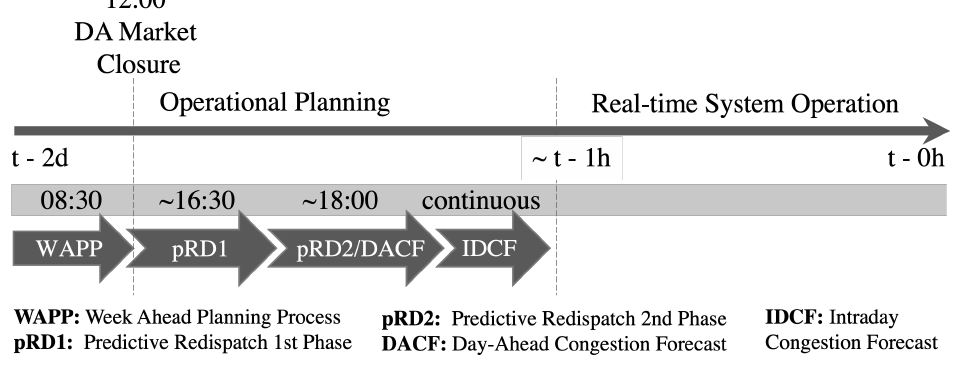
Figure 3. Timeline of the consecutive operational planning processes of the German transmission system operators. Graphical representation adapted from [31].